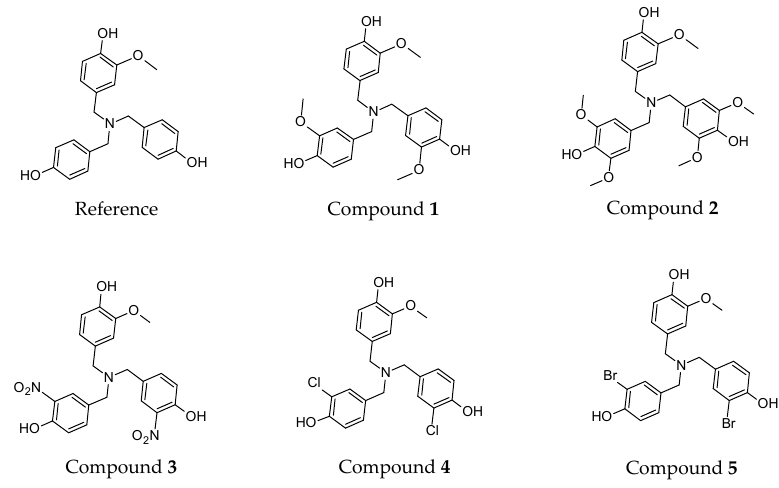
Figure 1. Structures of reference and target compounds 1–5 .